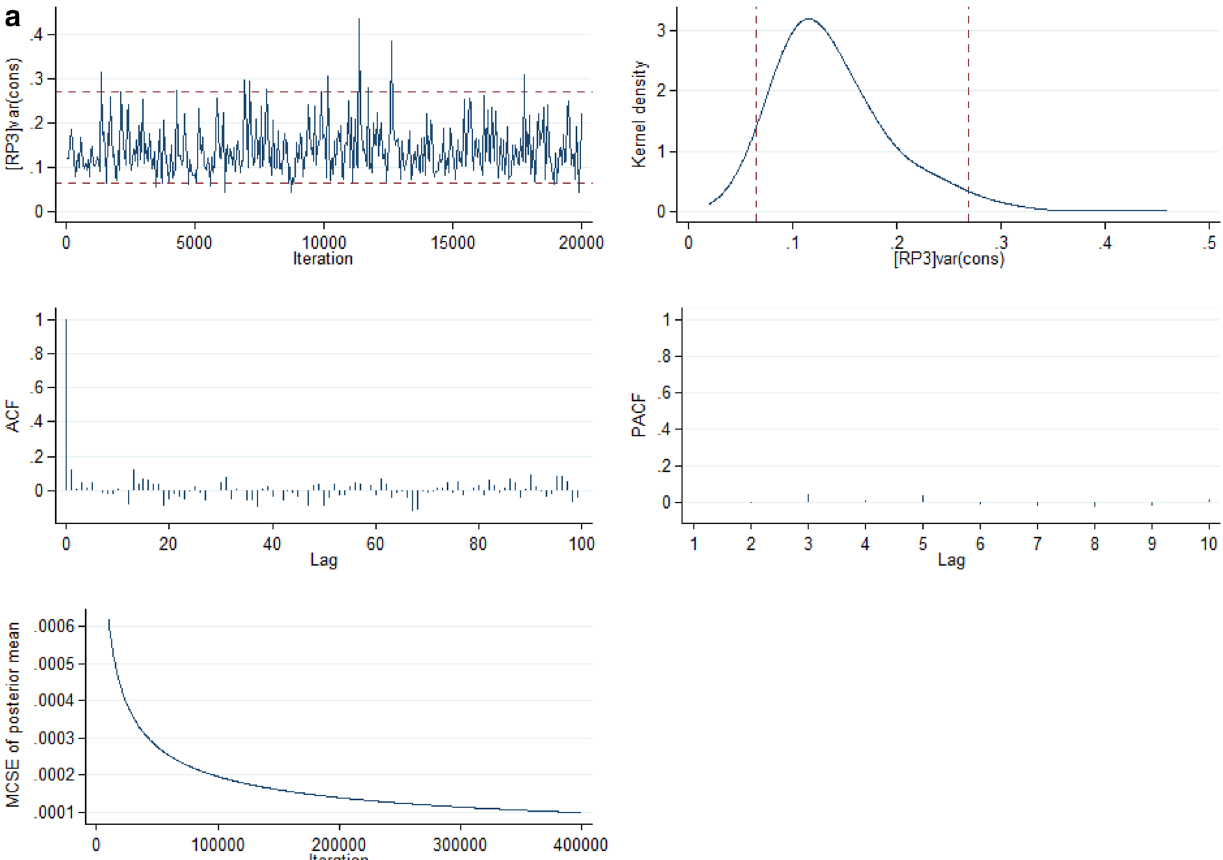
Figure 4. ( a ) Five-way MCMC graphical diagnostics of Model 5 for under-five mortality at the state level. ( b ) Five-way MCMC graphical diagnostics in Model 5 for under-5 mortality at the neighbourhood